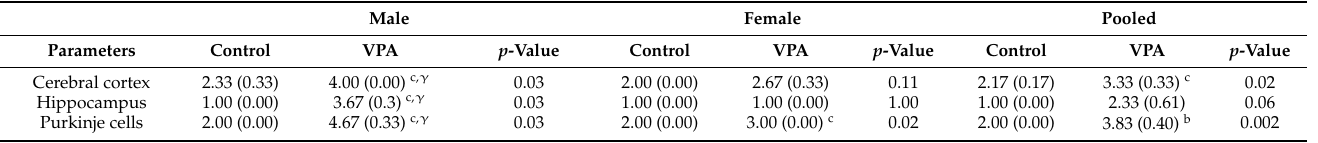
Table 3. The immunohistochemical staining scores of sex differences in control and VPA groups. Male Female